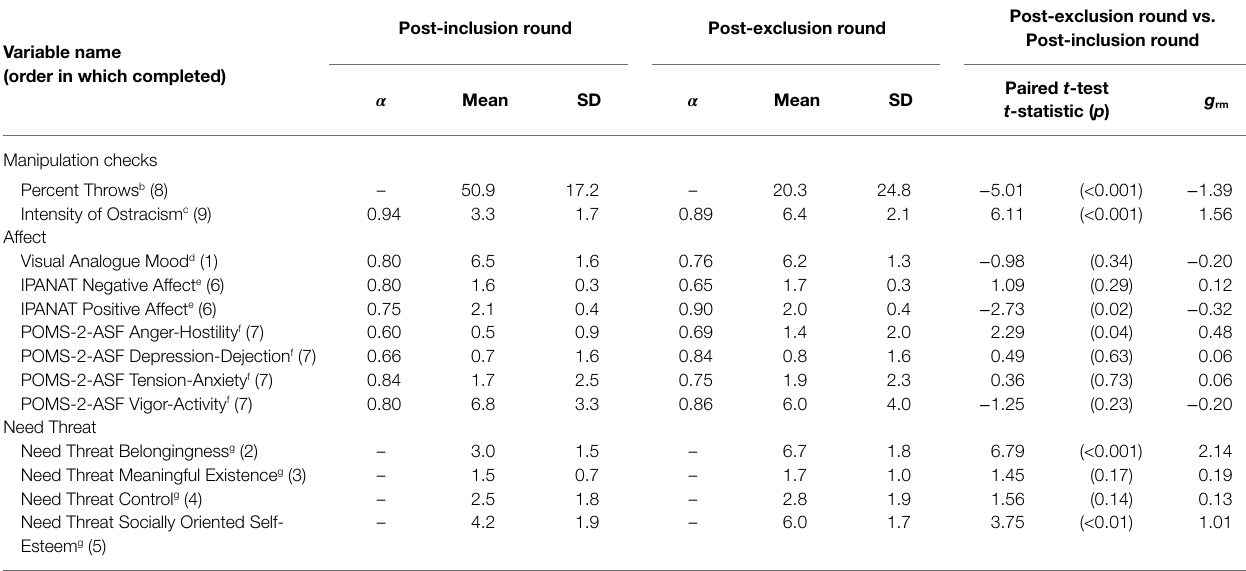
TABLE 2 | Comparison of manipulation check, affect, and need threat variables between exclusion and inclusion rounds of Cyberball. a